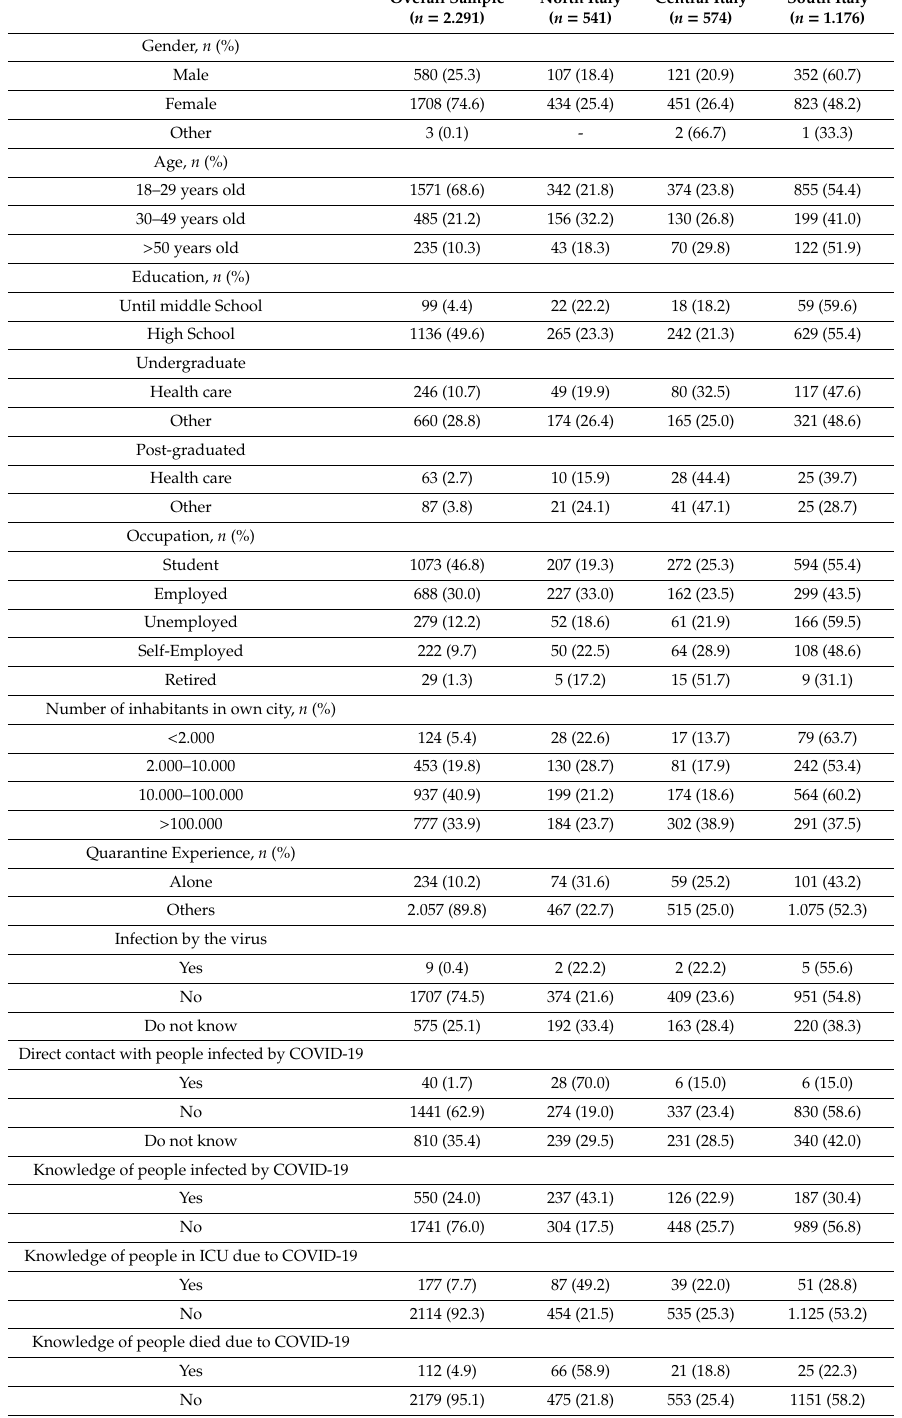
Overall Sample ( n =